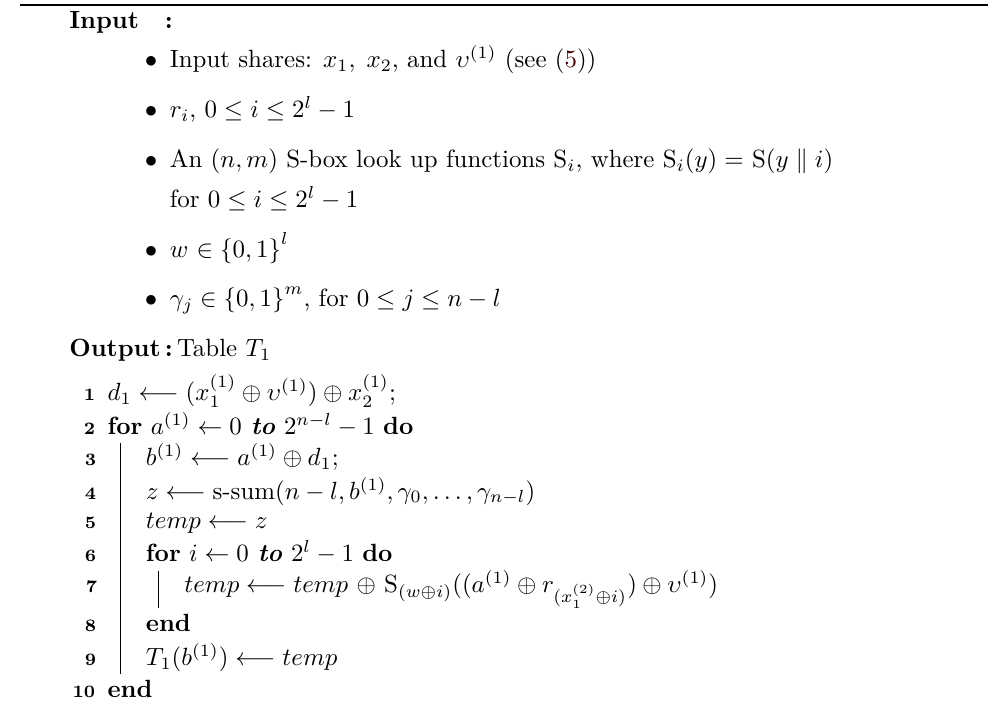
Algorithm 4: Computing T 1